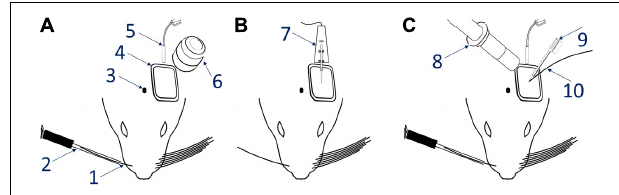
FIGURE 1 | Experimental setup. The left-most panel (A) shows the OI-IS recommended setup, before either microinjections or electrophysiology recordings. The middle panel (B) shows the optogenetics virus microinjection setup using a micropump directly connected to a mounted 10 microliter syringe. The right-hand panel (C) is the setup for acute electrophysiology recordings together with optogenetics photostimulation. 1 – Single whisker contralateral to imaging/recording site, 2 – Piezoelectric device with whisker adapter, 3 – Bregma marking on the skull, 4 – Cortical chamber with silicone chamber, 5 – 530 nm Optical Imaging illumination, 6 – Optical Imaging lens, 7 – Microinjector pump and syringe, 8 – Zoom lens imaging of the insertion site, 9 – Multichannel electrode, 10 – Optogenetics illumination and optic